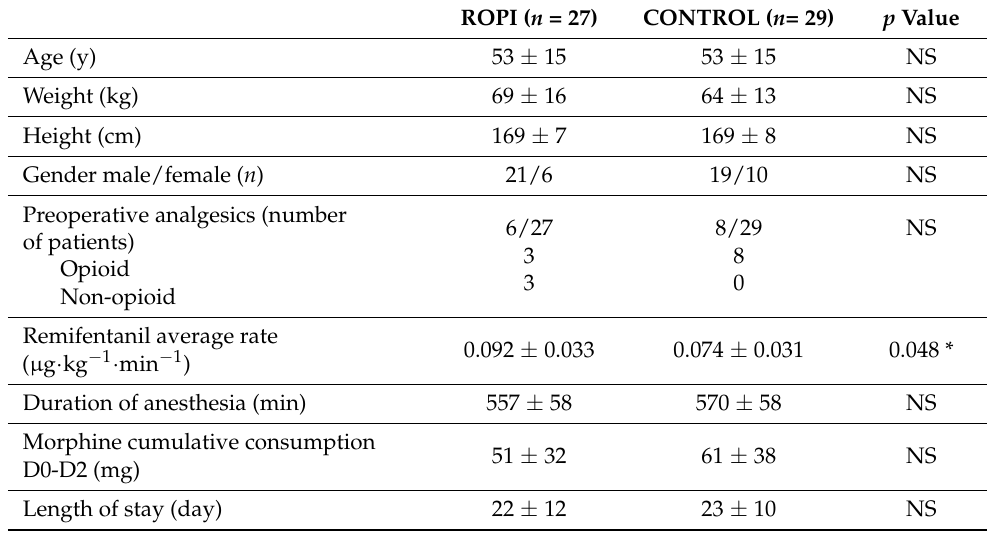
Table 1. Demographic and perioperative data (M ± SD).